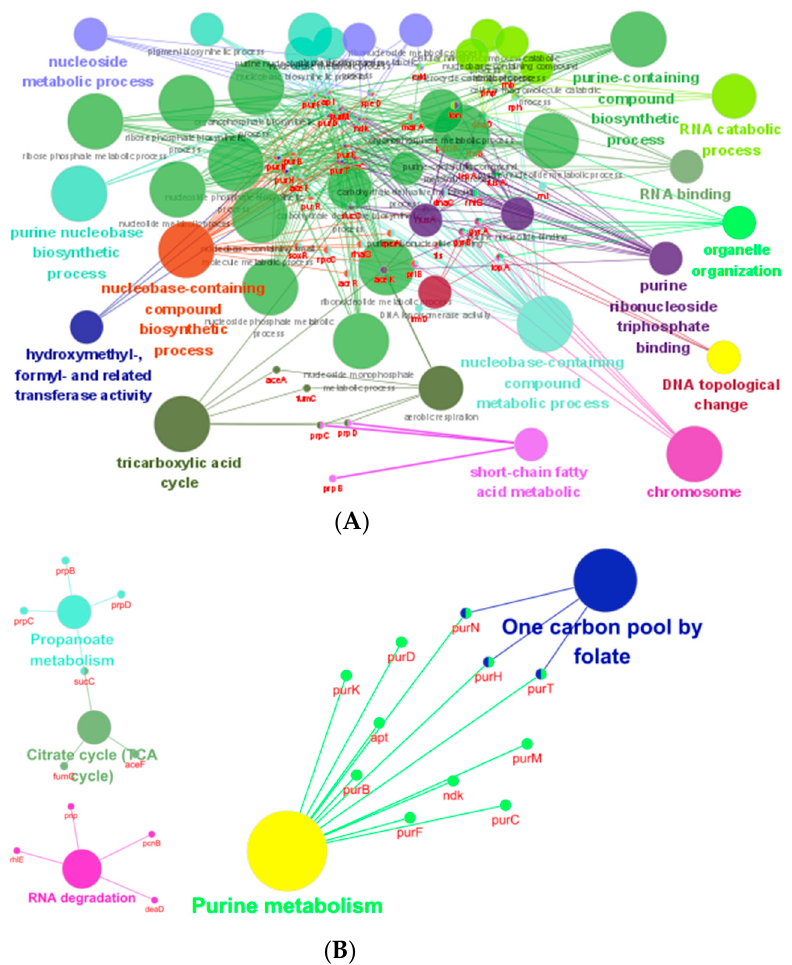
Figure 3. Enrichment analysis of GO and KEGG of genes that may be related to ENR resistance by ClueGO. GO term enrichment ( A ); KEGG enrichment ( B ).